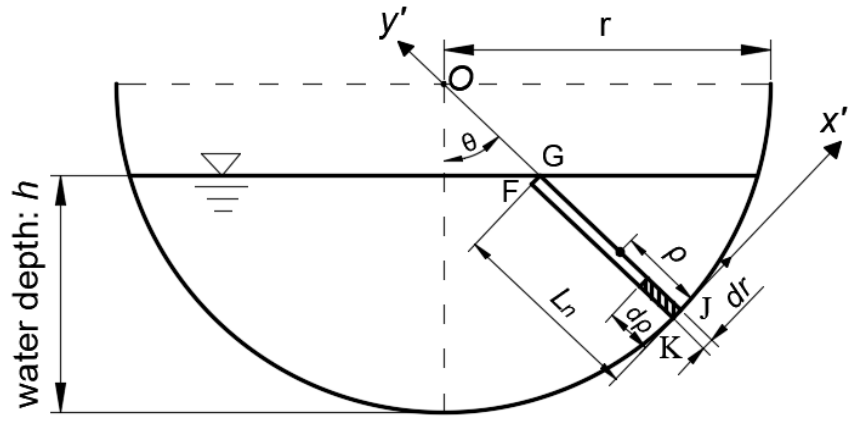
Figure 4. Section diagram of semi-circular channel.